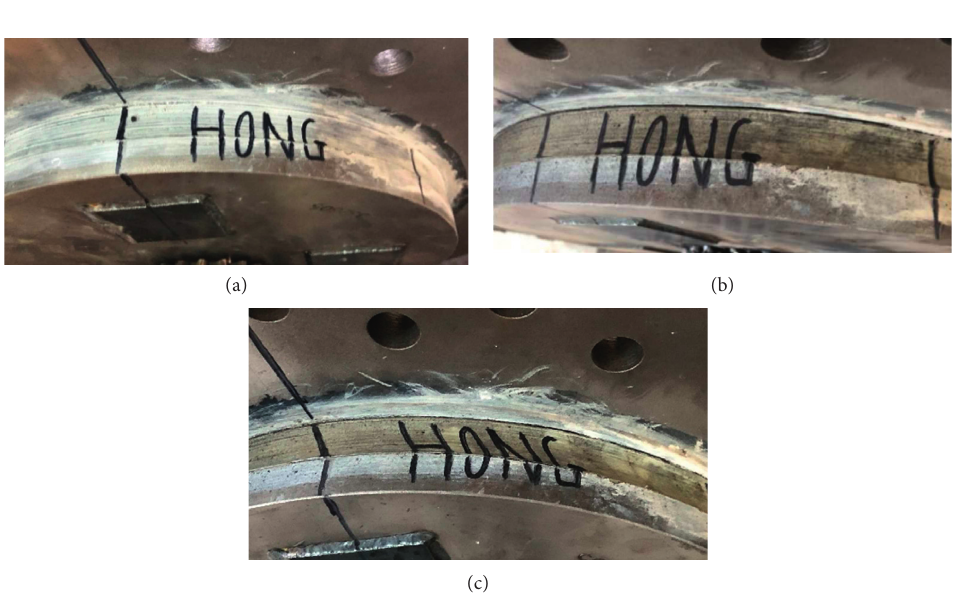
Figure 8: Loading process for Case 1. (a) Initial state. (b) Under 5mm displacement. (c) Under 15mm displacement.